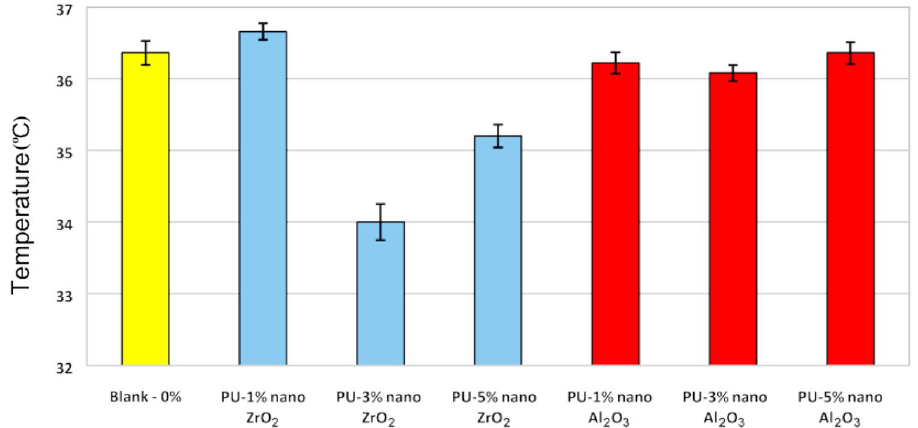
Figure 7. Temperature of the samples of polyurethane coating with 0, 1, 3, and 5% of nano ZrO 2 and Al 2 O 3